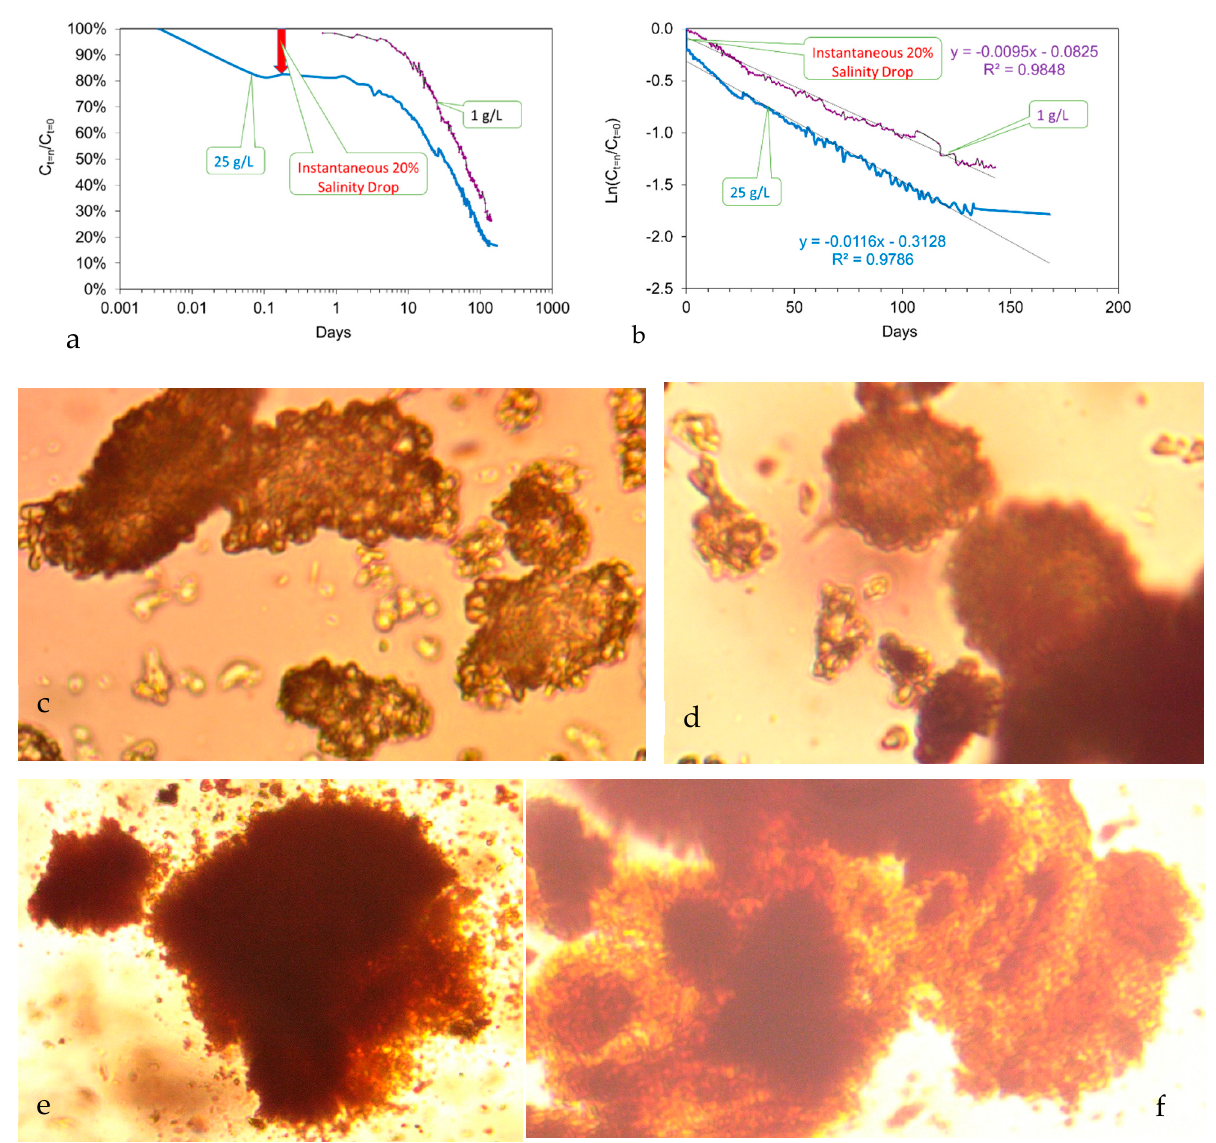
Figure 7. Example impact of changing P w (for P w = 25 g n-Fe 0 /L and 1 g n-Fe 0 /L on water salinity as a function of time; a s = 20 m 2 g − 1 ; (particle size 50 nm) coating: Fe 3 O 4 ; ( a ), [ C t = n / C t =0 ] versus reaction time, days; ( b ), Ln[ C t = n / C t =0 ] versus reaction time, days; temperature = <298 K; pressure = atmospheric (0.1 MPa); C t =0 = initial water salinity = 13.4 g/L. C t = n = water salinity at time t = n; static water body; 1 L volume. The desalination reaction is a first-order reaction, after the initial 10 days, and terminates after about 130 days; field of view = 0.17 mm; ( c ), colloid formation (0.01–0.1 mm) from the aggregation of fluid filled spheres, where n-Fe 0 surrounds a fluid core; ( d ), aggregation of the initial colloid aggregates to form a amorphous colloids. Field of view = 0.123 mm. ( e ), Aggregation of the initial colloid aggregates to form amorphous colloids. Field of view = 0.18 mm. ( f ), Aggregation of the initial colloid aggregates and fluid filled spheres, to form amorphous colloids. Field of view = 0.14